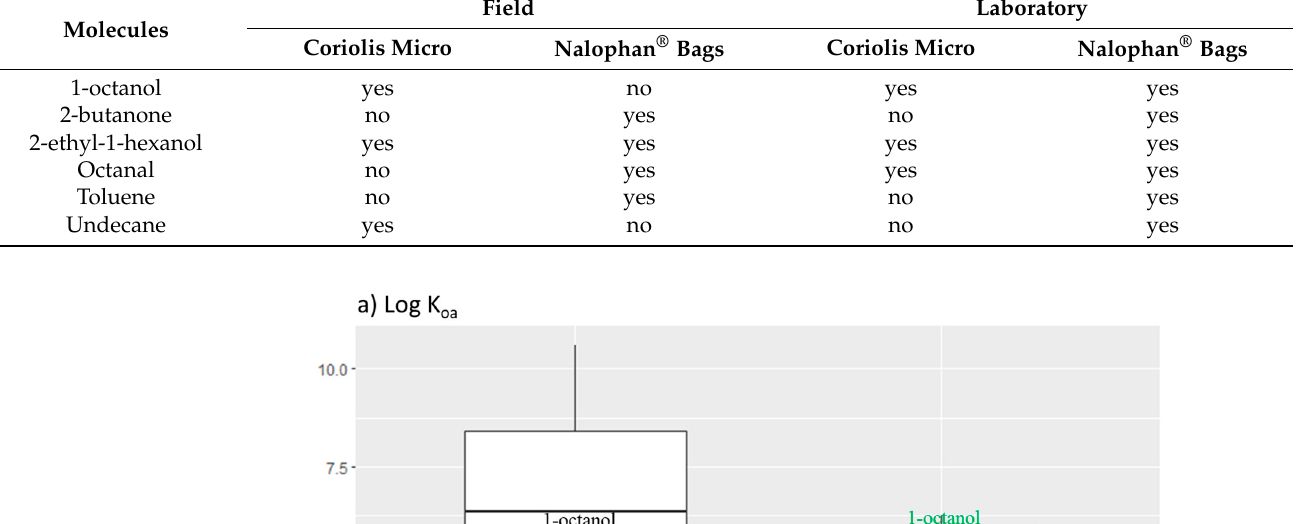
Table 1. Molecules detected (yes) or not (no) according to sampling type and place (lab/field), ( n = 3).